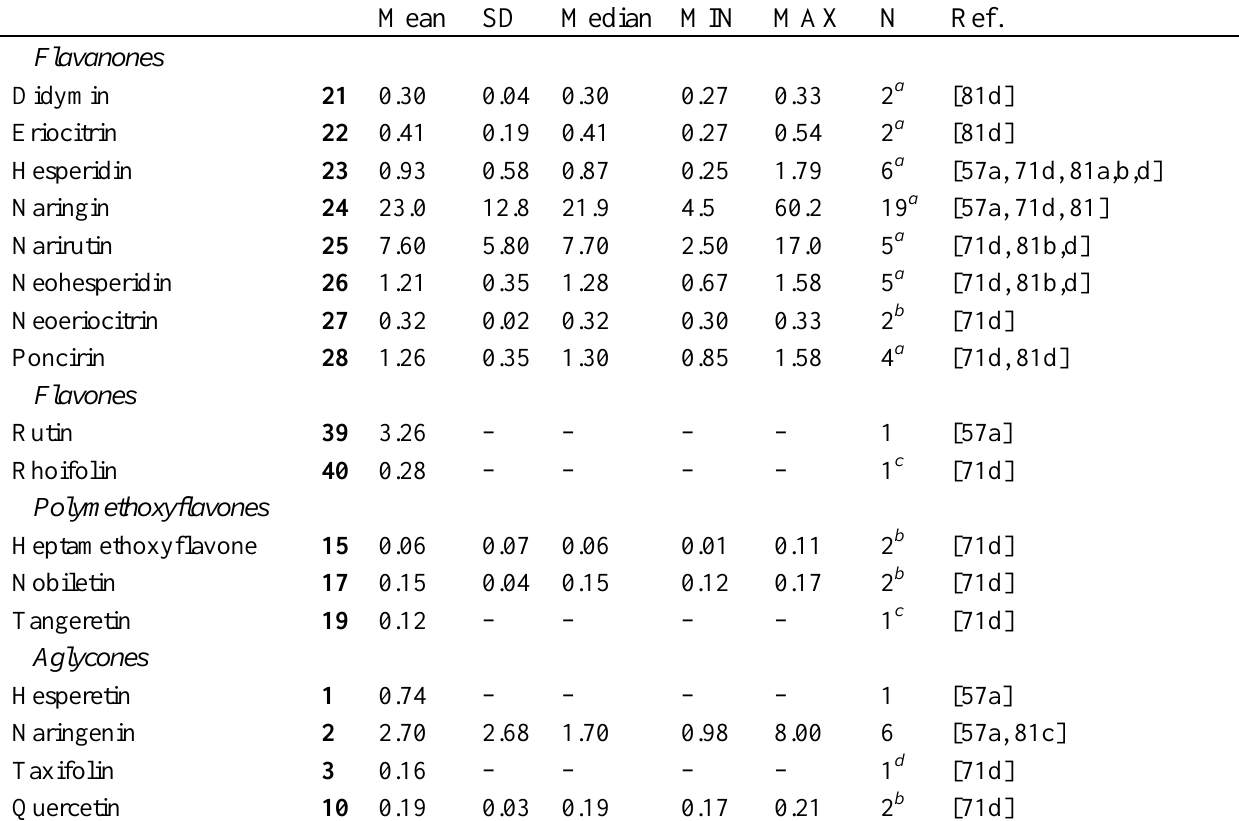
Table 17 . Flavonoid composition of C. paradisi juice (mg/100 mL).